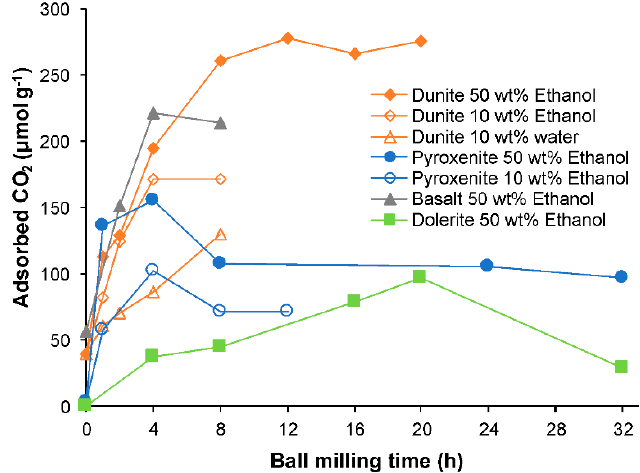
Figure 7. Adsorbed CO 2 ( μ mol g − 1 ) versus ball milling time (h) for the unmilled and ball-milled dunite, pyroxenite, basalt and dolerite samples (data from Rigopoulos et al. [19,25,32,33]). After ball milling, the dunite showed the highest enhancement of CO 2 uptake (278.1 μ mol g − 1 after 12 h of milling with 50 wt% ethanol), followed by the olivine basalt (222.1 μ mol g − 1 after 4 h of milling with 50 wt% ethanol), the pyroxenite (155.6 μ mol g − 1 after 4 h of milling with 50 wt% ethanol) and the dolerite waste material (96.9 μ mol g − 1 after 20 h of milling with 50 wt% ethanol) (Figure 7;